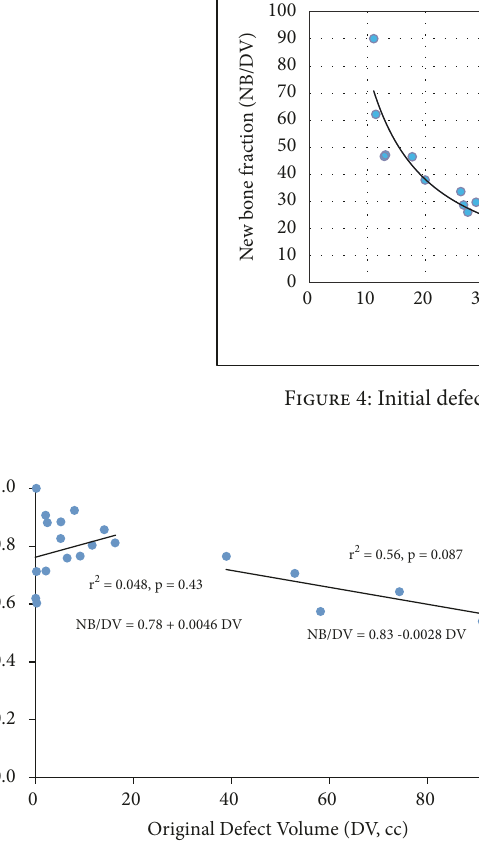
Figure 5: The new bone fraction (NB/DV) was greater for small defect volumes (DV). Overall, there was a significant decrease (p=0.0029) in NB/DV with increasing DV (r 2 =0.38). When sepa- rated into smaller ( < 20cc) and larger defect volume groups ( > 20cc), there was a trend towards decreased new bone fraction in the > 20cc group.